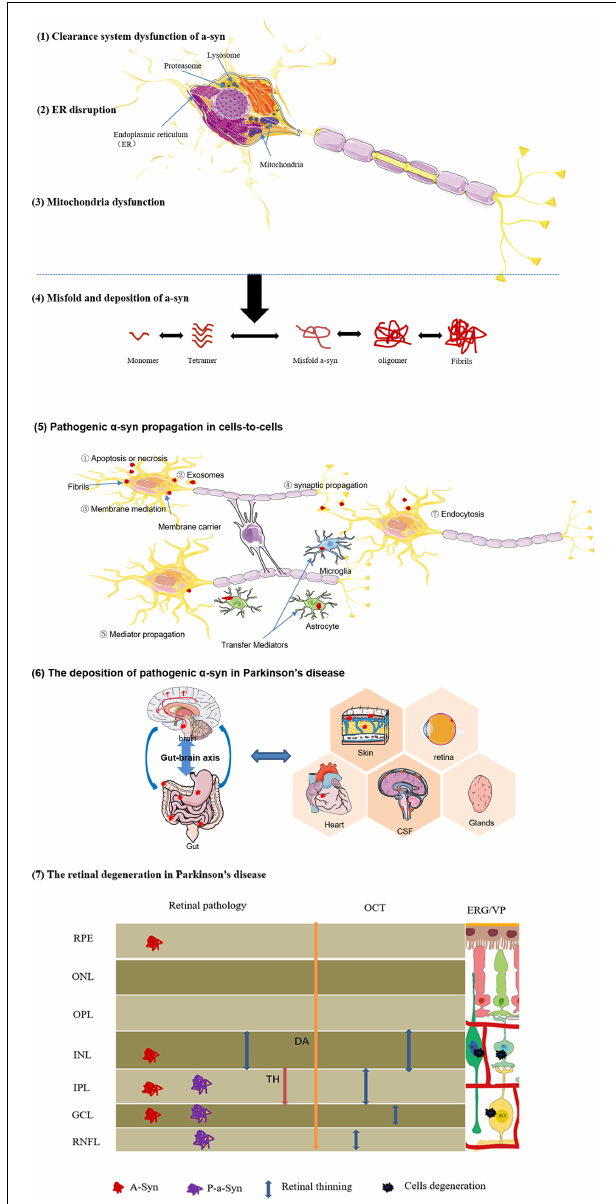
FIGURE 3 | Diagrammatic interpretation of the formation, propagation, and deposition of pathogenic a-synuclein. Certain risk factors effect on neurons, and initiate some pathological mechanisms associated with the etiology of PD, including (1) protein-clearance dysfunctions, (2) ER disruption, (3) mitochondria dysfunction. These pathological effects promote (4) abnormal a-Syn misfold and deposition. (5) Intercellular prion-like transmission of pathological a-Syn. Due to the propagative mechanisms of a-Syn similar to prions, abnormal proteins are released and transmitted via different mechanisms:Apoptosis or necrosis,exosomes,membrane mediation,synaptic propagation,mediator propagation, and so on. (6) The deposition of pathogenic α -syn in Parkinson’s disease. For the definitive derivation of a-Syn, the brain-first hypothesis and gut-first hypothesis appear to be better received in current research. Especially, pathological a-Syn also was found in retina, skin tissue, heart, CSF, and glandular secretions. These pathological changes are critical for interpreting and understanding of clinical symptoms of patients with PD. (7) The retinal degeneration in Parkinson’s